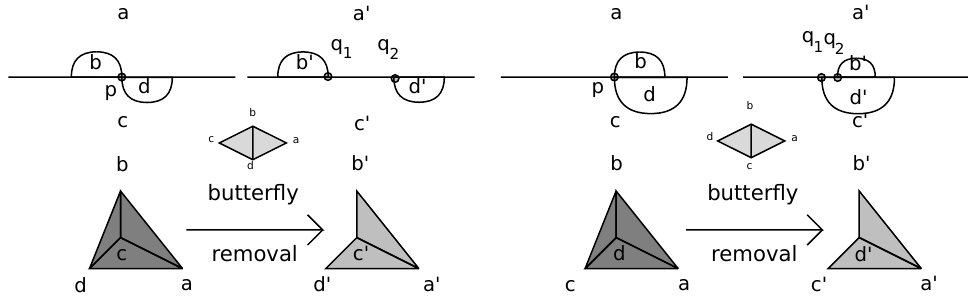
Figure 4. Splicing and removing tetrahedra together with their corresponding